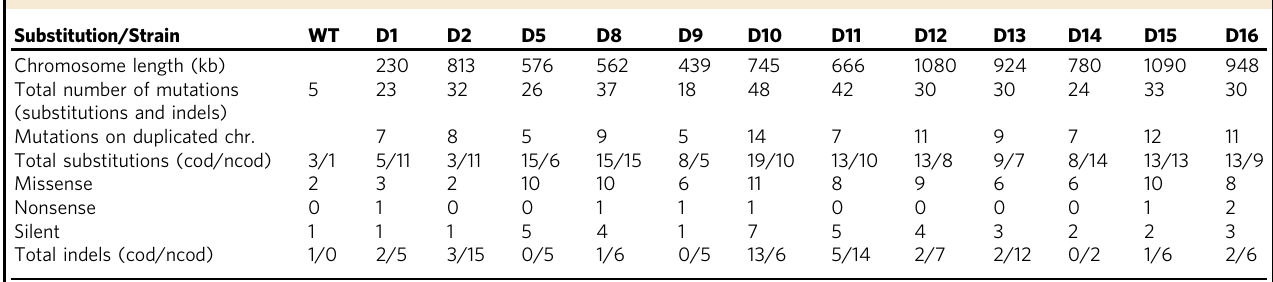
Table 1 Mutations observed in evolved lines compared to their ancestors.